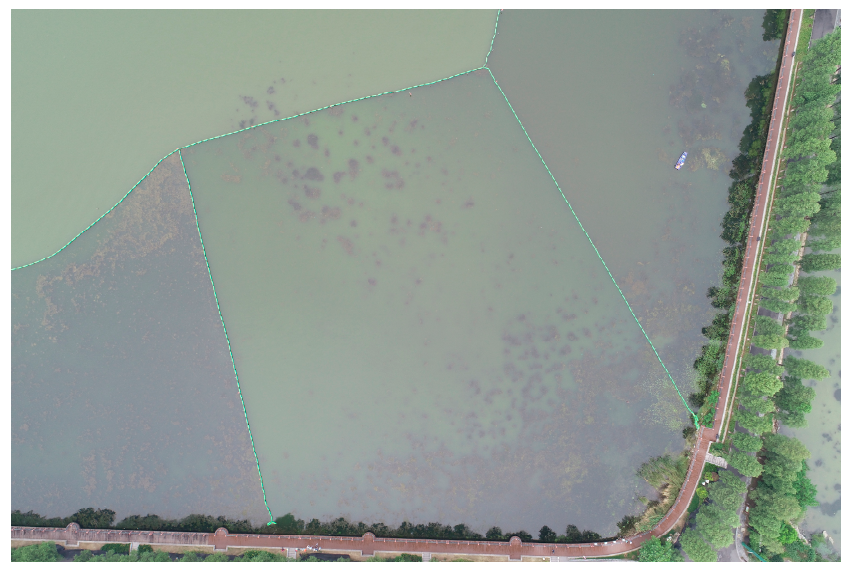
Figure 1. Enclosure used for the restoration of submerged macrophyte in East Lake, Wuhan, China.